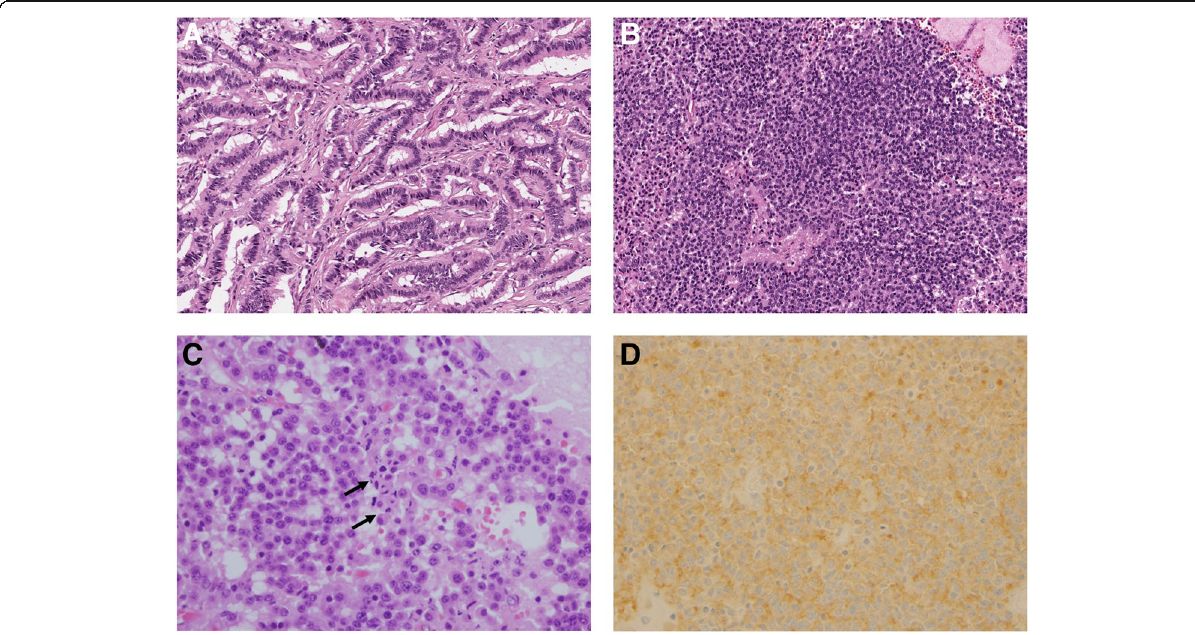
Fig. 2 Histologic features of case with lymph node and liver metastasis. Mixed ribbon-like ( a , × 200) and sheet-like ( b , × 200) patterns are observed. Also many apoptotic bodies are observed ( c , × 400). Synaptophysin showed diffuse positive staining ( d , × 400)